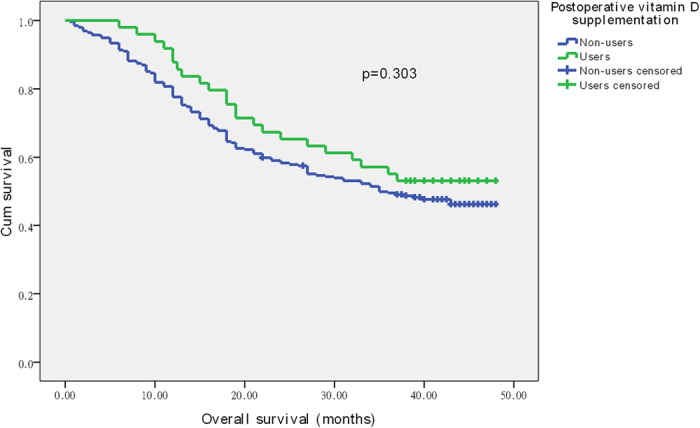
Overall survival related to postoperative vitamin D supplementation.